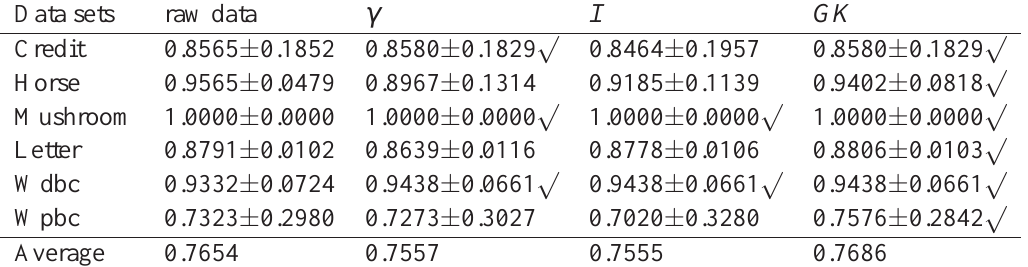
Table 10: Comparison of classification accuracies based on different methods with C4.5 Data